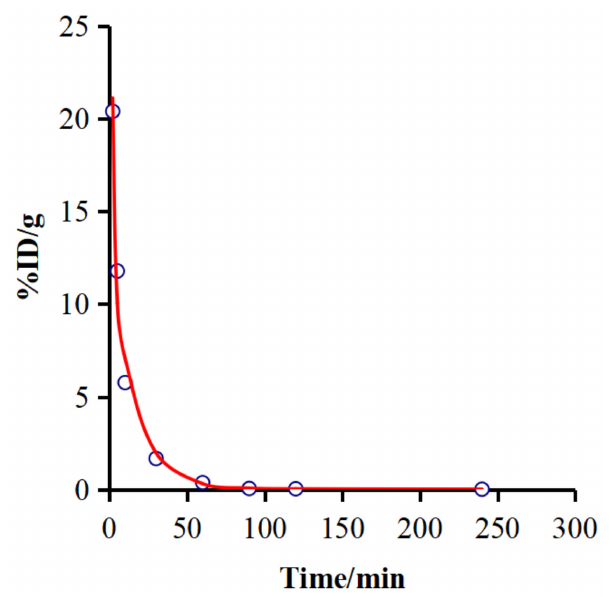
Figure 6. Time-activity curve of [ 99m Tc]Tc-CNMCHDG in the blood of healthy Kunming female mice ( n =